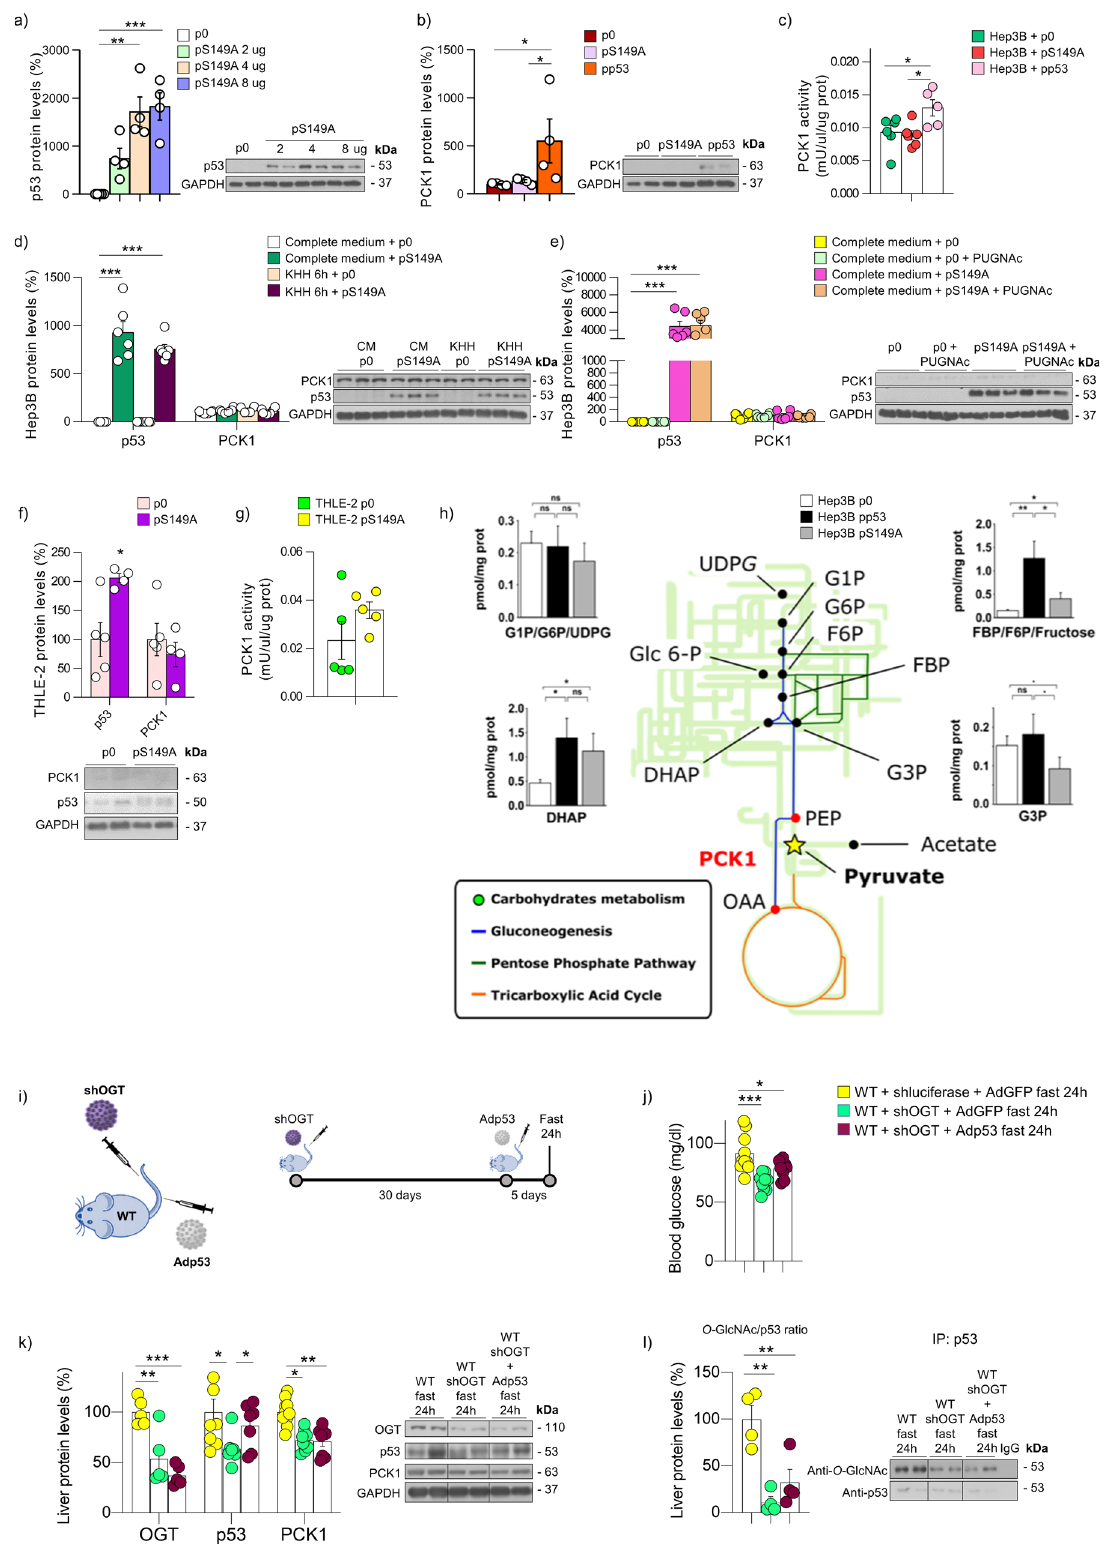
induced gluconeogenesis (a common pathway between glucagon and adrenaline), we carried out p53-S149A mutagenesis in Hep3B treated with forskolin and found that, while it induced increases of pCREB and p53, this compound was not able to upregulate PCK1 protein levels when p53 was mutated (Supplementary Fig. 8a).